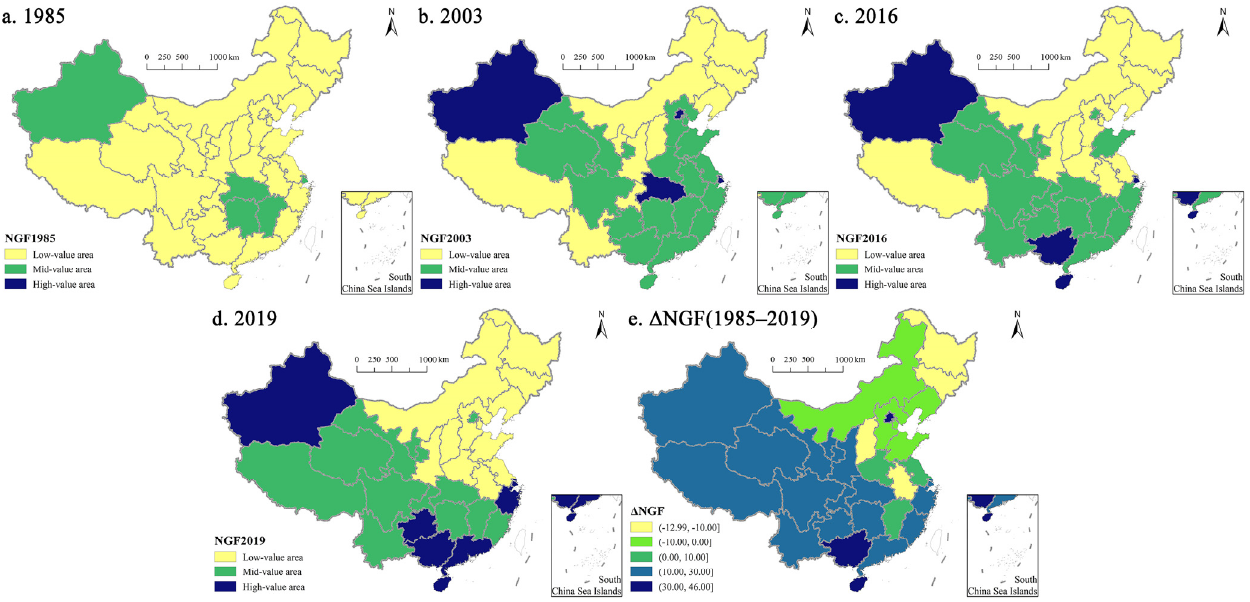
Figure 2. Spatial patterns of NGF and its changes in China from 1985 to 2019 ( a – e ). In terms of the changes in NGF from 1985 to 2019, there were only nine provinces with declining NGF, mainly distributed in North and Northeast China, with this decline averaging − 7.63%. Among them, the provinces with an increase of NGF below − 10% were Heilongjiang ( − 12.99%), Shanxi ( − 11.91%), Jilin ( − 11.49%) and Anhui ( − 10.92%). By contrast, there were 22 provinces with a rising NGF, and the average value was 20.12%. Specifically, the provinces with an increase of NGF greater than 30% were Hainan (45.06%), Guangxi (31.72%) and Beijing (30.29%); and three provinces had an increase in NGF less than 10%, that was, Jiangxi (0.99%), Jiangsu (2.86%) and Henan (4.32%) (Figure